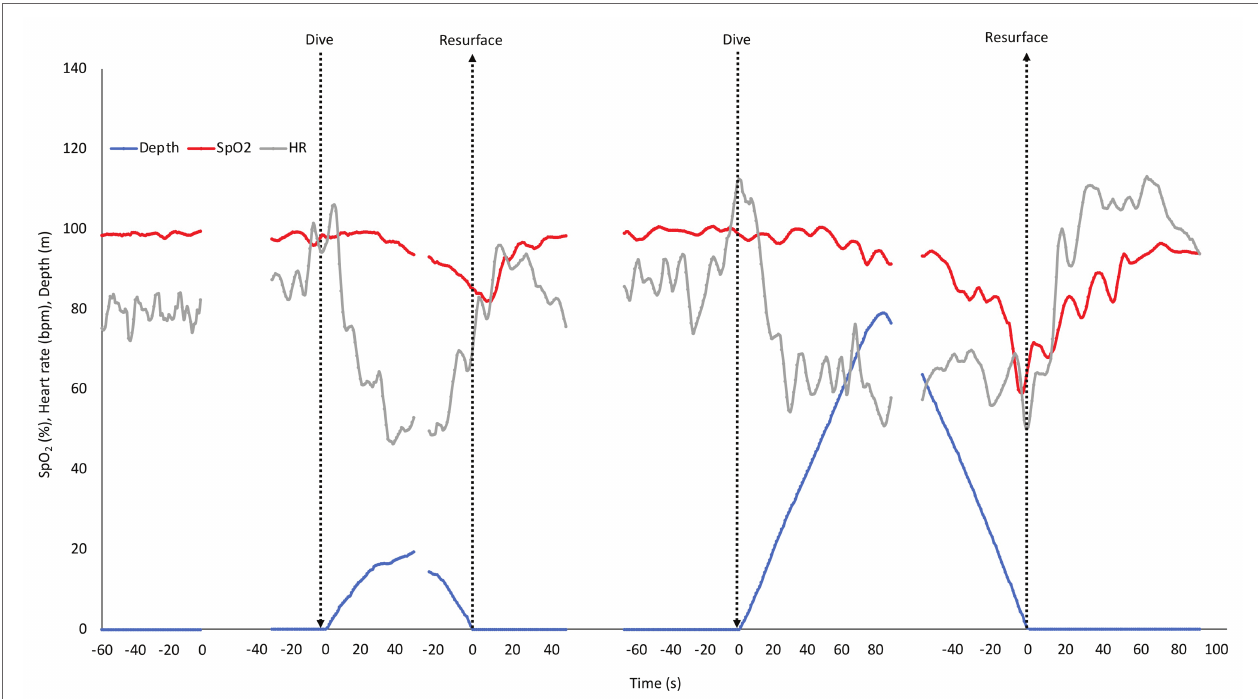
FIGURE 3 | Mean depth, SpO 2 , and HR response pattern during rest before dives and in three of the four shallow and deep dives. SD has been left out for clarity. The shallow and deep dives with the shortest durations were not included to allow longer means. Arrows indicate start and end of dives, and also marks the two points, where dives were aligned for calculations. Gaps represent ommitted parts in the middle of the dives with the longest